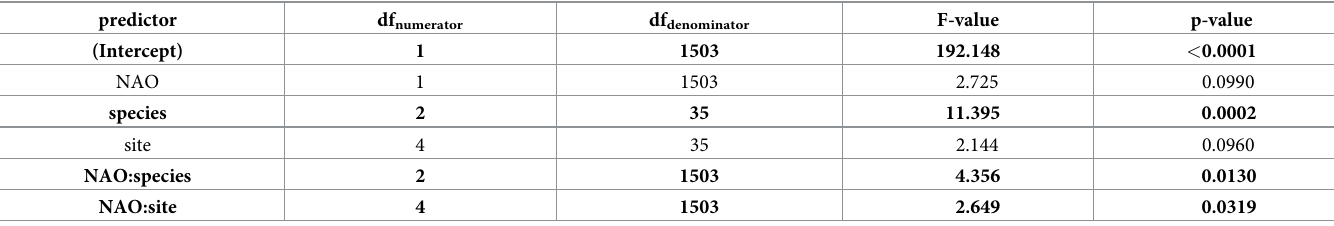
“Predictor” represents the model parameter, “df numerator ” and “df denominator ” represents numerator and denominator degrees of freedom, respectively, “F-value” represents the F statistic for each predictor, and each “p-value” less than α = 0.05 is in bold text.